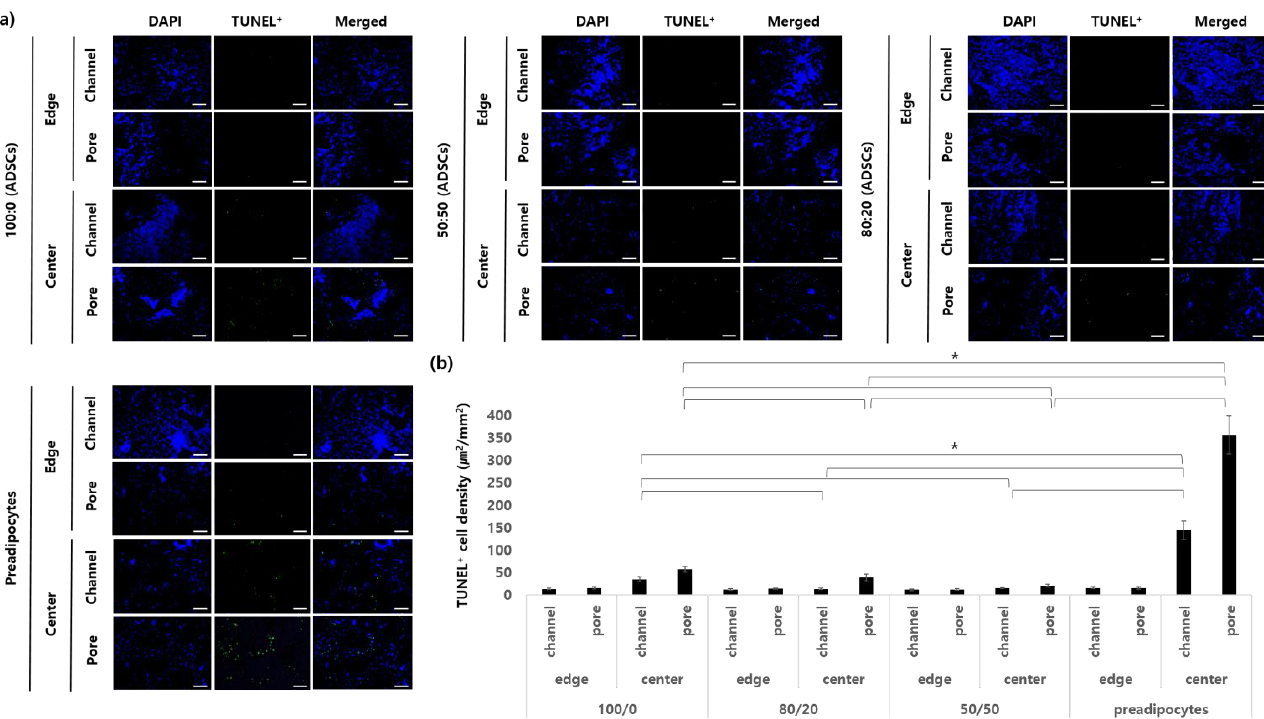
Figure 5. Apoptosis of seeded cells in a construct. ( a ) Representative immunostaining of apoptotic cells. ( b ) Quantification of the stained area (μm 2 /mm 2 ). Scale bar: 100 μm (* p < 0.05).